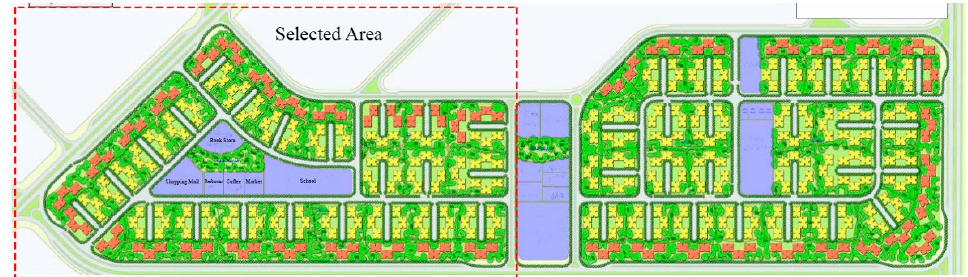
Figure 3. shows the layout of the neighborhood in Salam New City. Source: Adapted by the re- Figure 3. Shows the layout of the neighborhood in Salam New City. Source: Adapted by the searchers retrieved from [43]. researchers retrieved from